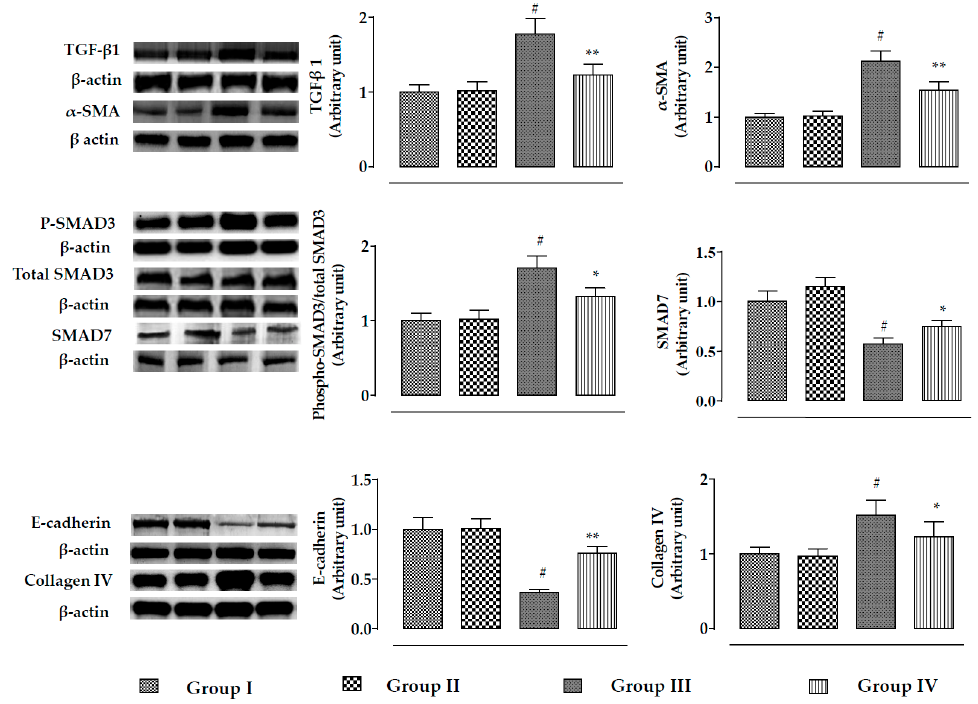
Figure 11. The e ff ects on TGF- β 1, α -SMA, SMAD3 SMAD7, E-cadherin, and collagen-IV expressions in the absence (CdCl 2 ) and presence of RA (CdCl 2 + RA) in vivo on mouse kidneys. The relative band intensities were assessed, and the intensity of the normal control band was assigned as 1. β -Actin served as the loading control. Data are represented as means ± SD, n = 6 (number of plates). # Values significantly ( p < 0.01) differ from normal control. * Values significantly ( p < 0.05) differ from CdCl 2